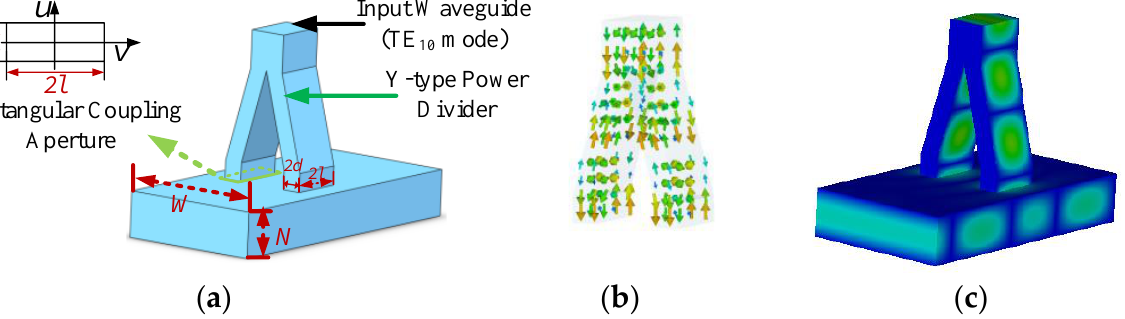
Figure 2. Schematic of a TE 01 mode converter. ( a ) Vacuum structure. ( b ) Magnetic field distributions in the power divider. ( c ) Electric field distribution in the mode converter.